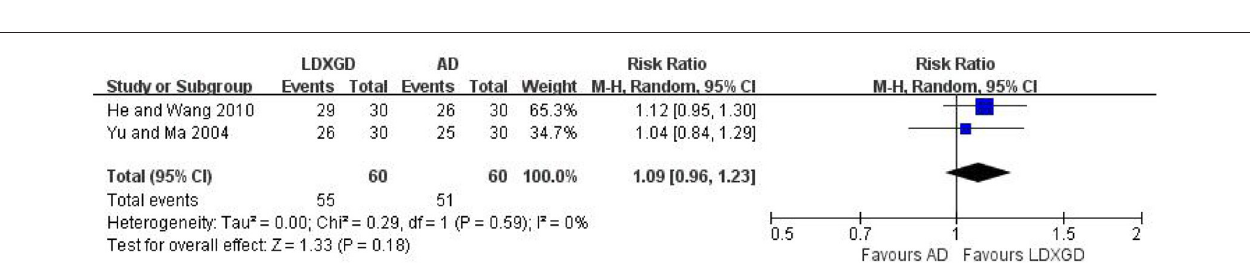
FIGURE 3 | Forest plots of the comparison of LDXGD vs. antihypertensive drugs for the outcomes of BP. AD, antihypertensive drugs; BP, blood pressure; LDXGD, longdanxiegan